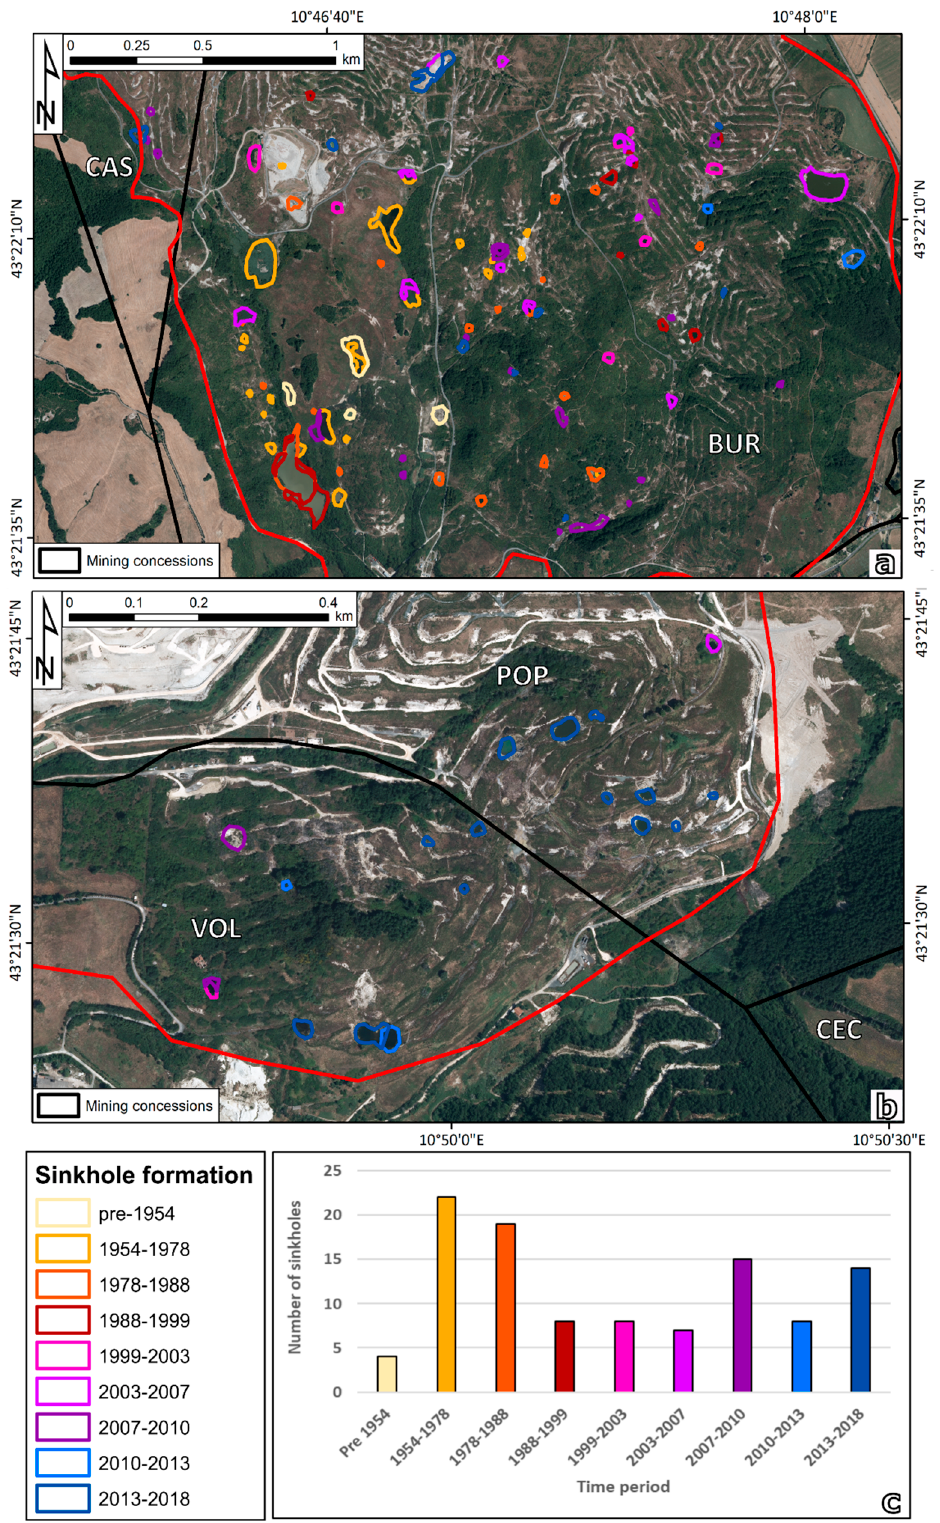
Figure 3. Sinkholes catalogue for the mining concessions of Buriano-Casanova ( a ) and Poppiano-Volterra ( b ). The background image is an AGEA 2018 orthophoto (Table 1). The distribution of boreholes for temporal periods is presented in inset c . Sinkholes with contour variations are counted as their first appearance.